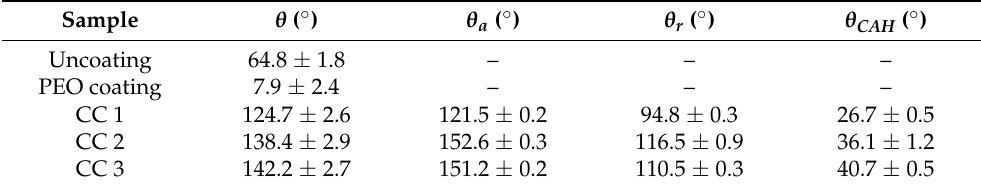
Table 5. Wettability of the AMg3 aluminum alloy samples with various types of surface treat- ment: θ —contact angle, θ CAH –contact angle hysteresis, θ a –advancing contact angle, and θ r –receding contact angle.